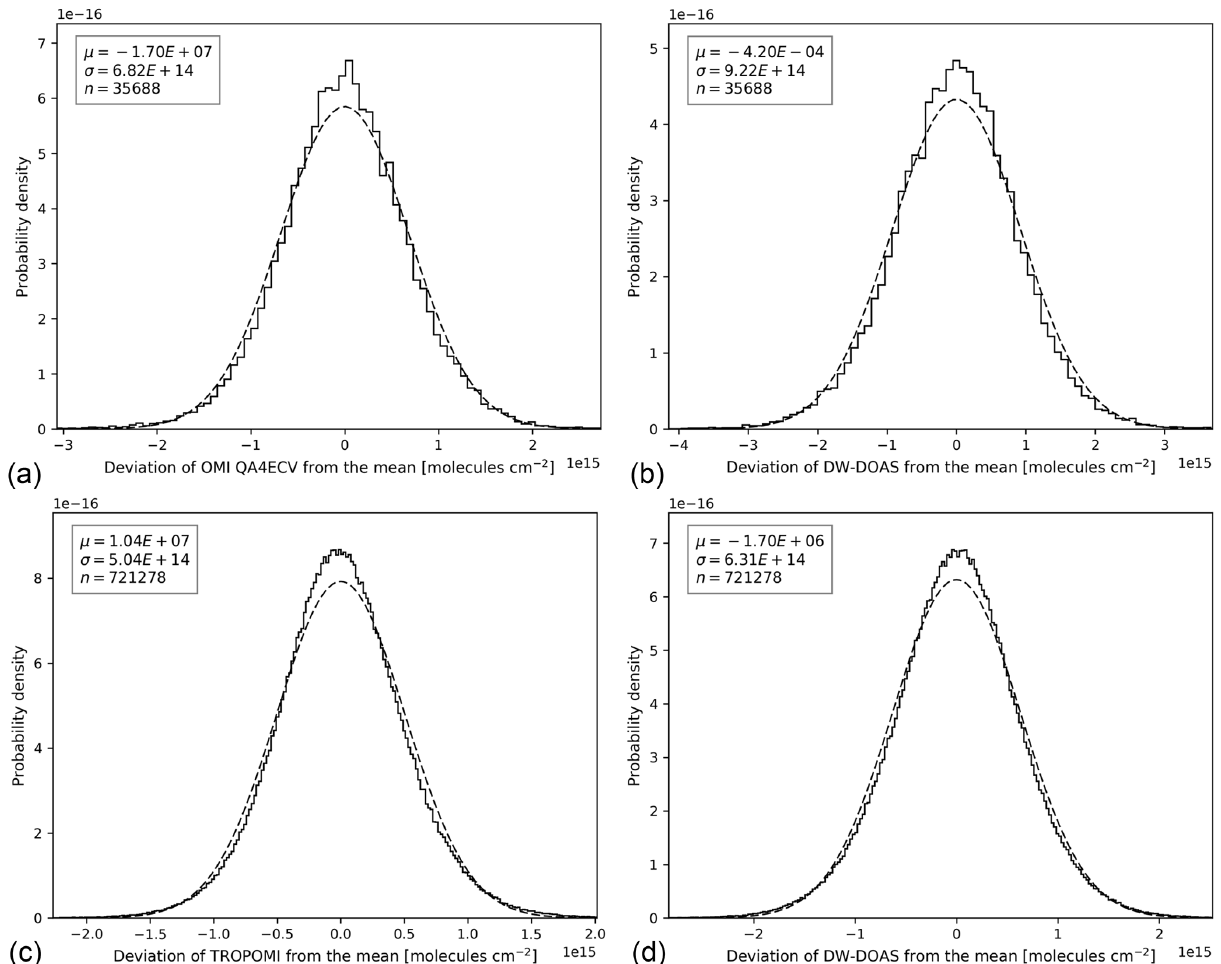
Figure 11. Histogram of the deviation of the NO 2 SCDs from the box mean for OMI (a, b) and TROPOMI (c, d) , for DW-DOAS (b, d) and the corresponding reference products (a, c) . OMI data have not been screened for clouds; TROPOMI data have been screened using the quality assurance value (qa > 0 . 5) from the level 2 NO 2 product. The data shown are from January 2005 (OMI) and January 2019